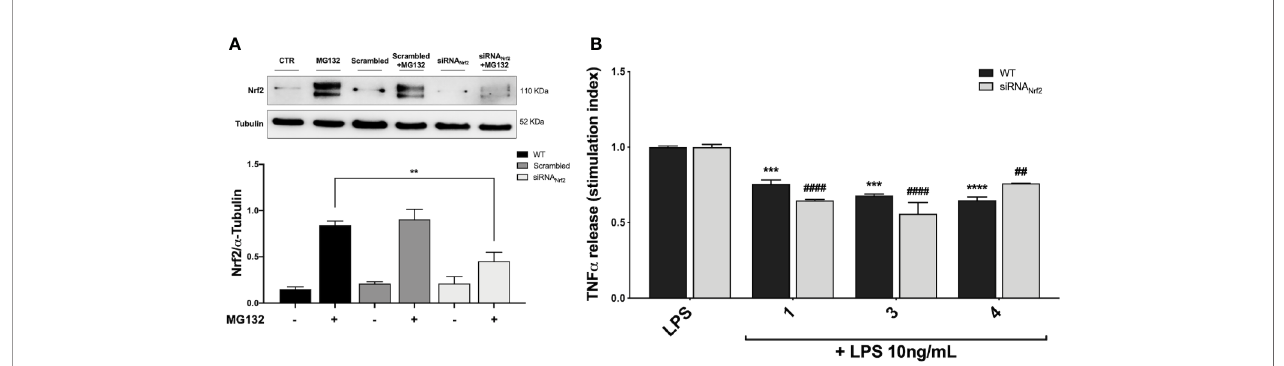
FIGURE 5 | Optimization of Nfr2-silenced THP-1 model (A) and effect of Nrf2-knockdown on modulation of TNF a release by compounds 1, 3 and 4, upon LPS stimulation (B) . (A) THP-1 cells were treated either with vehicle (WT), scrambled or siRNA Nrf2 for 24 h. Where indicated MG132 was added 4 h before the end of the experiment to block the proteasomal degradation of Nrf2. After treatments, Nrf2 expression was determined in total protein extracts by Western blot analysis using an anti-Nrf2 antibody. Anti- a -tubulin was used as protein loading control. Results are shown as means of Nrf2/ a -Tubulin ratio ± SEM. Unpaired Student t -test; ** p < 0.01; n = 3. (B) TNF a amount was measured in the supernatants of THP-1 Nrf2-knockdown cells, treated with compounds 1, 3, and 4 at a concentration of 5 m M for 24 h and then stimulated with 10 ng/mL LPS for 3 h. The protein secretion of TNF a was determined by ELISA. Data are shown as means of stimulation index ± SEM. Dunnett ’ s multiple comparison test; *** p < 0.001 and **** p < 0.0001 versus WT LPS; ## p < 0.01 and #### p < 0.0001 versus siRNA Nrf2 LPS; n =